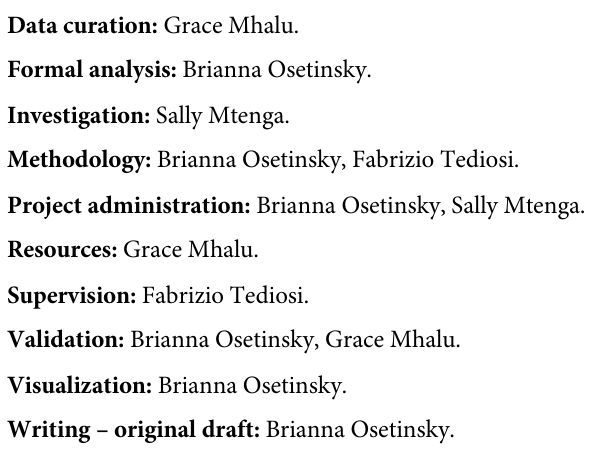
S1 Table. Population-adjusted prevalance and care cascade for hypertension and diabetes. S2 Table. Care cascade number of events in each stage of the care cascade. S3 Table. Reasons why medication was not obtained at the last healthcare visit. S4 Table. Sensitivity analysis, regression results for the outcome engagement in care vary- ing definition of engaged in